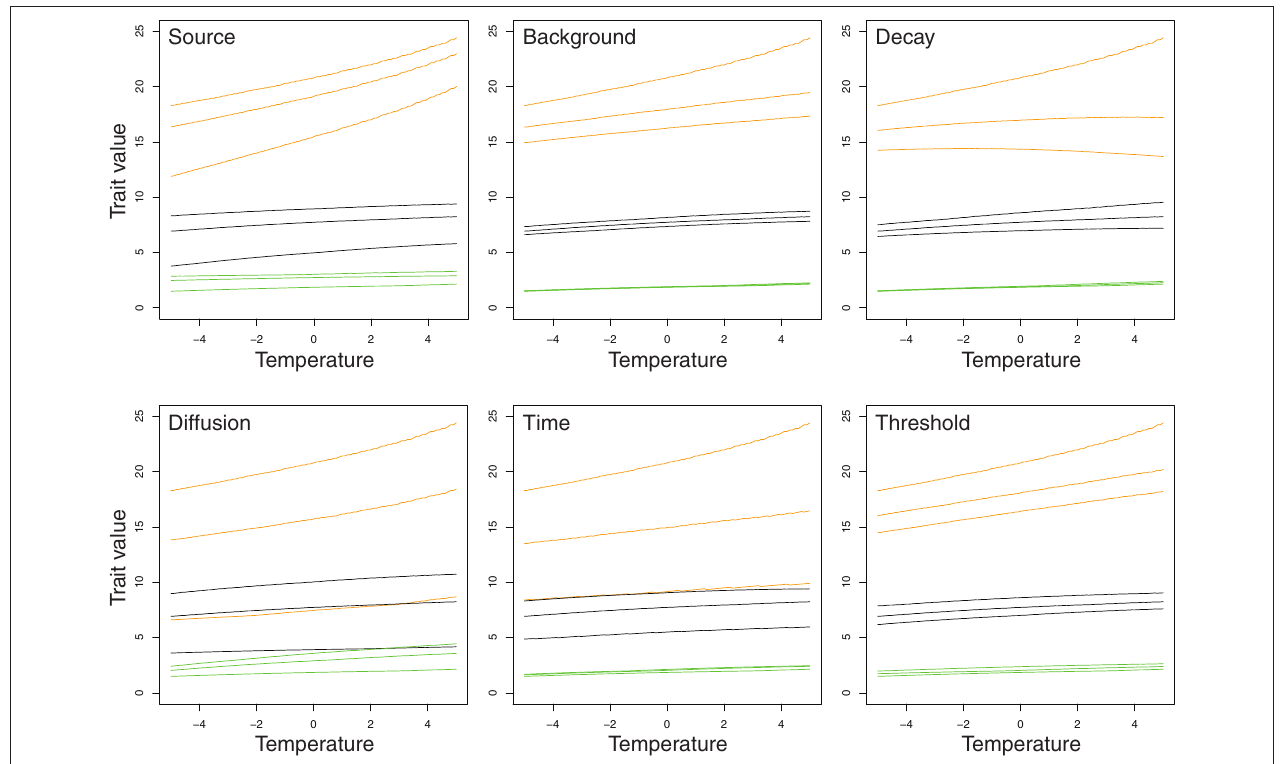
FIGURE 4 | Reaction norms of the target phenotype of the trait vs. temperature for different genotypes in the loci controlling the developmental parameters. The reaction norms are drawn for a range of 5 ◦ above and below the reference temperature, which is designated by a value of zero. Each panel shows three groups of reaction norms according to the genetic background, that is the genotype in the five loci other than the focal locus of the respective panel: green curves are for the SS genotype in those five loci, black for the SL genotype, and orange for the LL genotype. Within each of those three groups, the curve at the top is for the LL genotype of the focal locus for the panel, the middle curve is for the SL genotype, and the curve at the bottom is for the SS